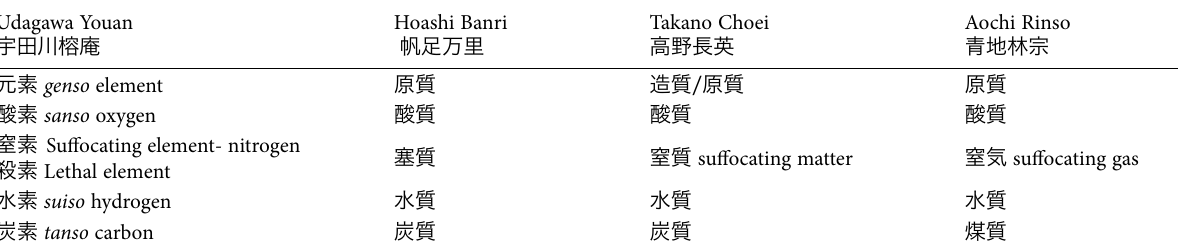
Table 2. Choices of kanji for element by Udagawa Youan and other scholars. Udagawa Youan